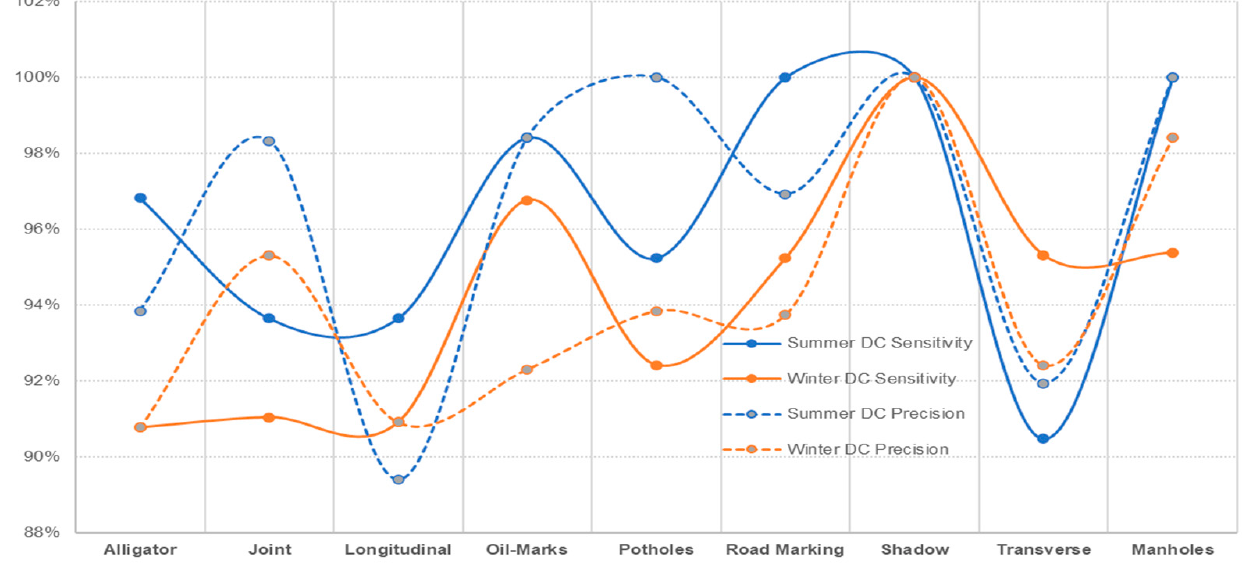
Figure 14. Winter conditions—sensitivity and precision.